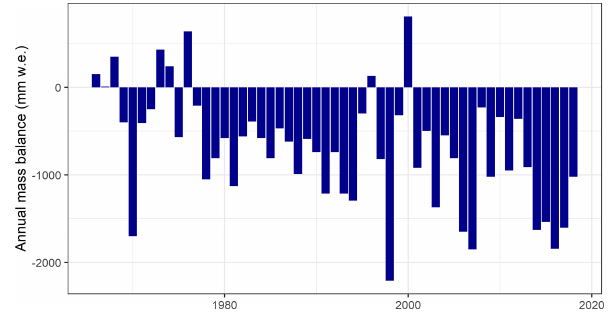
Figure 17. Net annual mass balance data for Peyto Glacier. Data source: WGMS